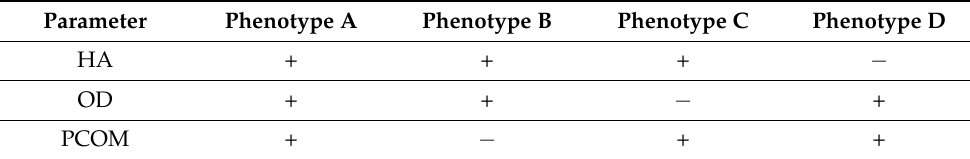
Table 1. Classification of polycystic ovary phenotypes (modified from references [7,18]).